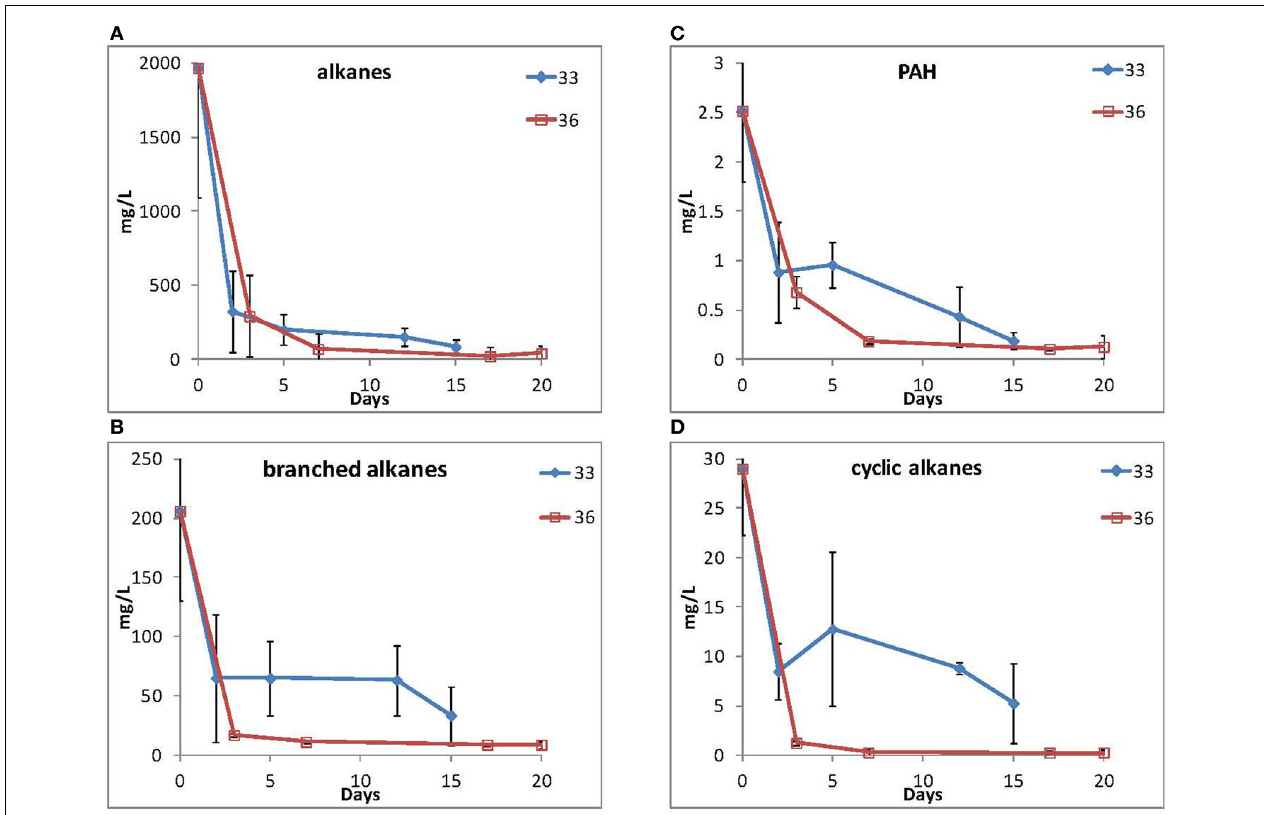
FIGURE 5 | Loss of (A) straight alkanes, (B) branched alkanes, (C) PAHs, and (D) cyclic alkanes during incubation by isolate 33 ( Marinobacter spp .) and isolate 36 ( Roseobacter spp